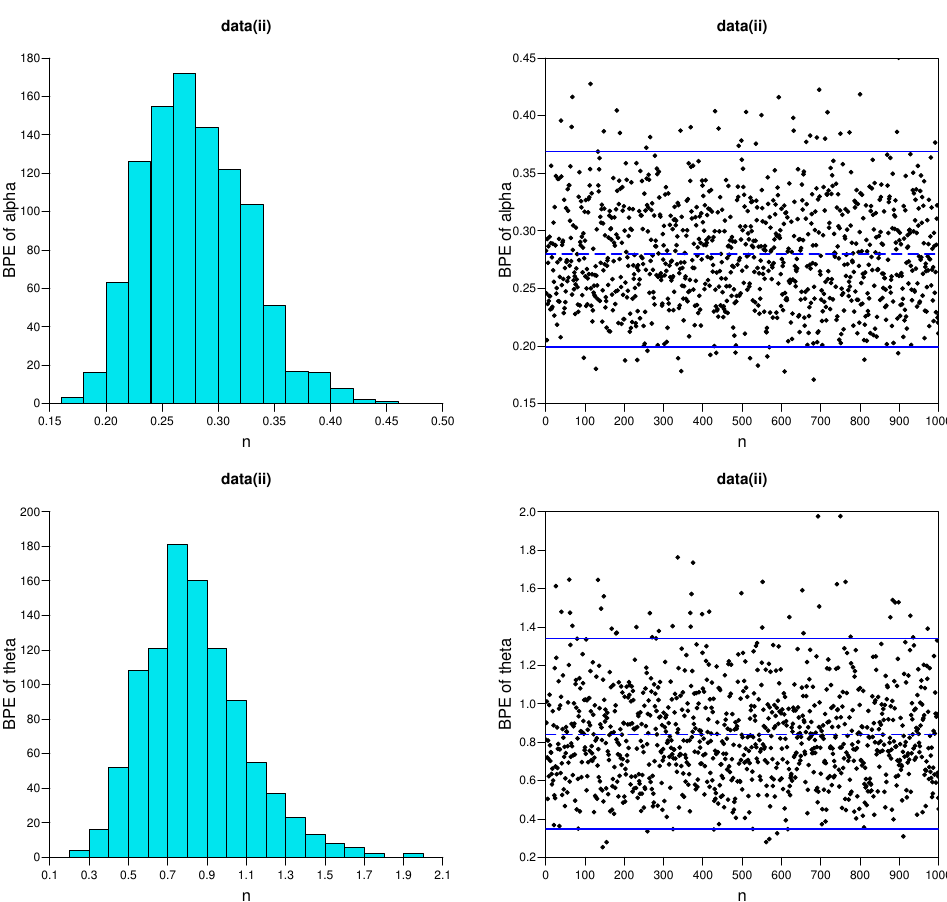
Figure 9. Trace plots (the posterior mean (dashed line) with 95% credible intervals (solid lines)) and corresponding histograms of BPEs of α and θ for data set